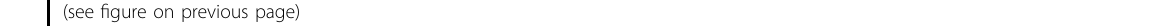
Fig. 1 Cryo-EM and mechanistic studies of LdGDP-MP. a Overall views of hexameric LdGDP-MP with six subunits colored differently. The real density maps are shown in grey mesh. b Ribbon diagrams of a LdGDP-MP monomer. c Detailed interface contacts between neighboring subunits. d , e Magni fi ed views of GTP- ( d ) or GDP-Man- ( e ) binding pocket with the real density map of GTP or GDP-Man shown in mesh. f Catalytic center of LdGDP-MP. g Activity comparisons of LdGDP-MP with mutants as labeled. h Impacts on the enzyme activity upon mutations for disrupting the interface-1 of LdGDP-MP. i Proposed evolutionary pathway of GDP-MPs from bacteria to human in terms of activity modulation. All enzyme assays were repeated at least three times and data were shown as means ±